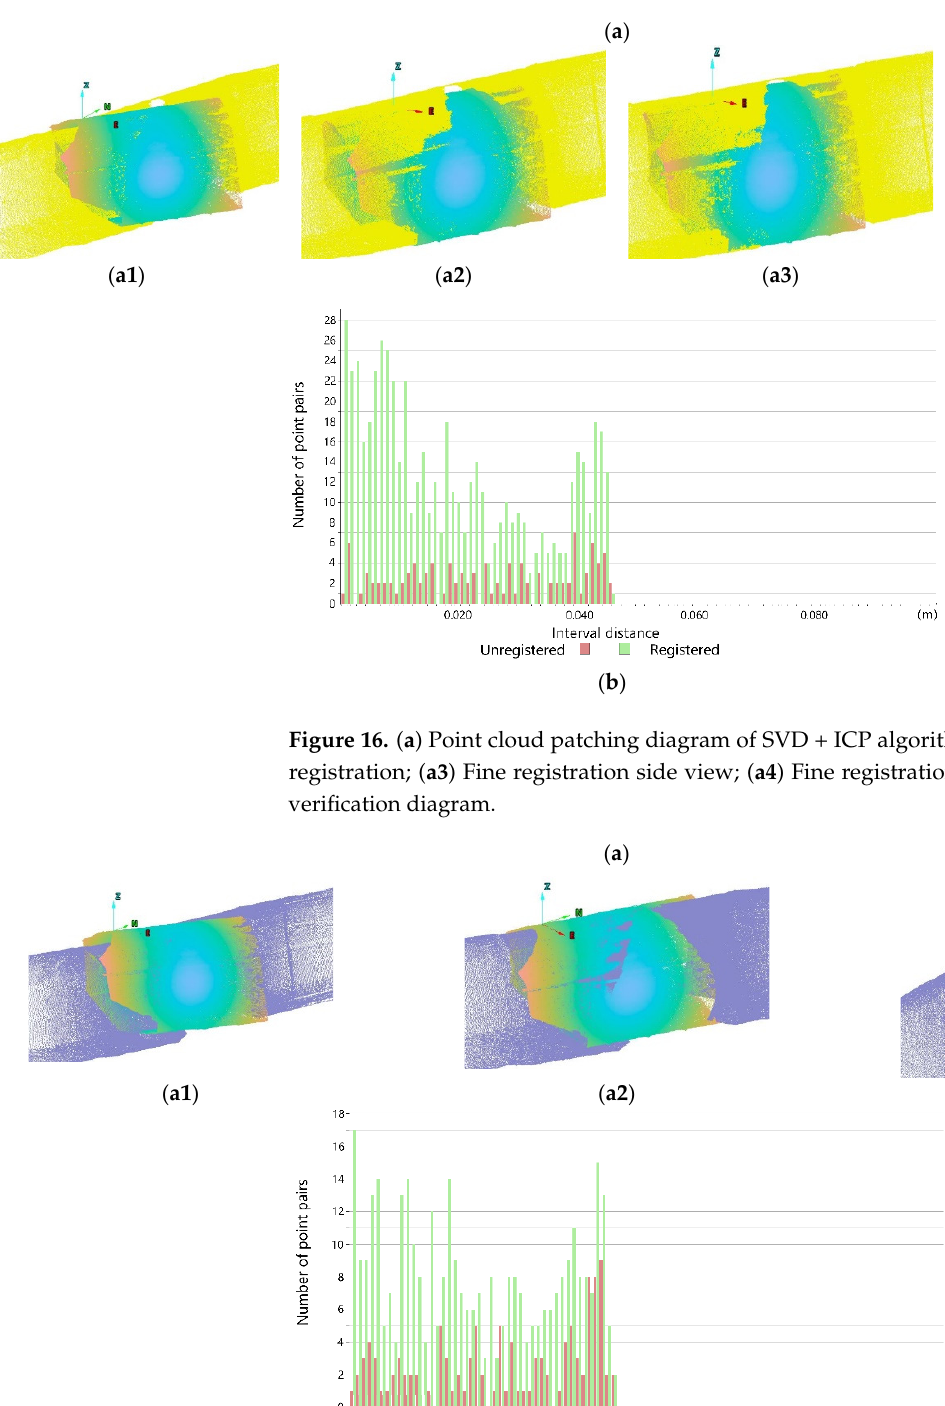
( a4 ) ( b ) Figure 15. ( a ) Point cloud patching diagram of ISS + ICP algorithm. ( a1 ) Initial pose; ( a2 ) Coarse registration; ( a3 ) Fine registration side view; ( a4 ) Fine registration top view. ( b ) Fine registration verification diagram. 5.3. Point Cloud Patching of SVD + ICP Algorithm The singular value decomposition (SVD) algorithm is a matrix decomposition algo- rithm based on the sum of squares of minimum error to solve the objective function. It can reduce the dimension of the target feature space, thereby obtaining the feature description